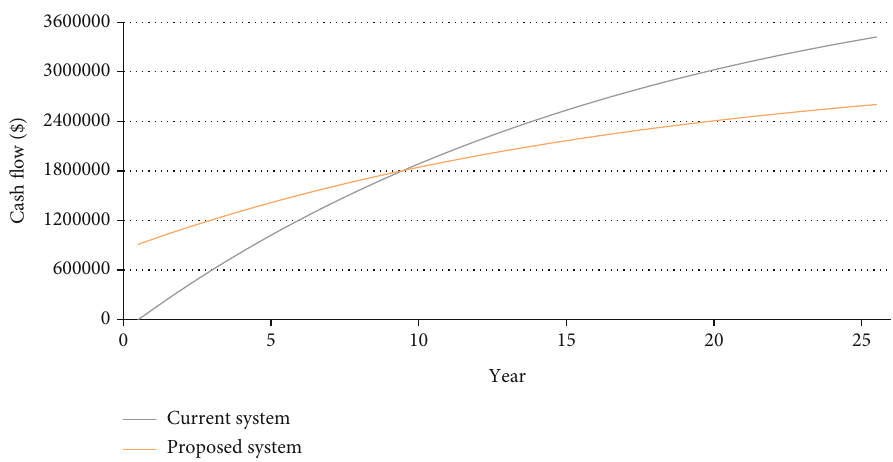
Figure 50: Cumulative cash fl ows over project lifetime for the current and proposed systems for Rwanda.